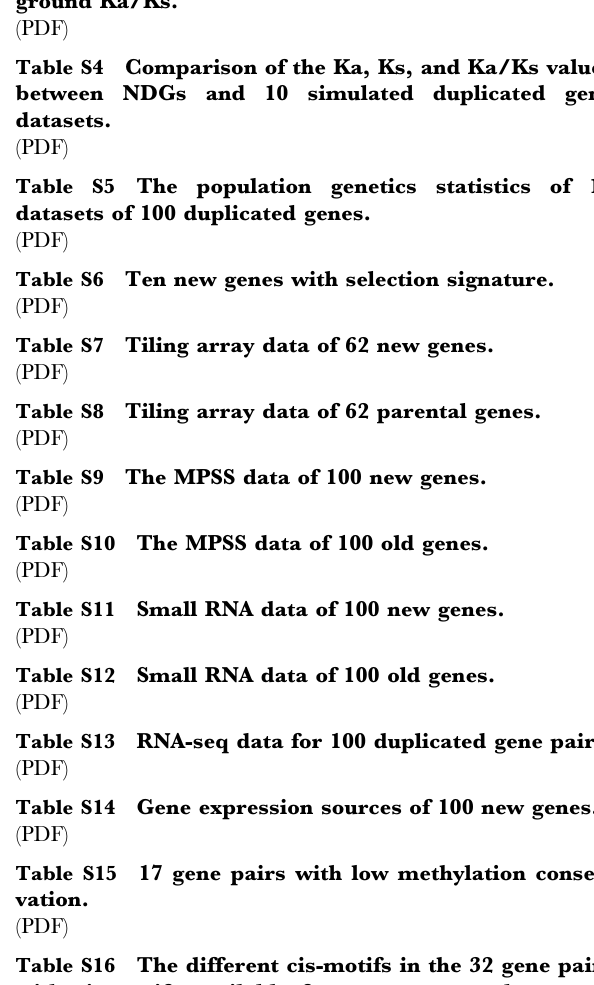
Figure S1 Illustration of segmental duplication. Figure S2 Tandem duplication defined by synteny. Figure S3 Tandem duplication defined phylogenetic analysis. Figure S4 Example of emipirical distribution of Taja- ma’s D statistic values obtaied from a large data set. The red line indicates the Tajima’s D values from a single NDG.